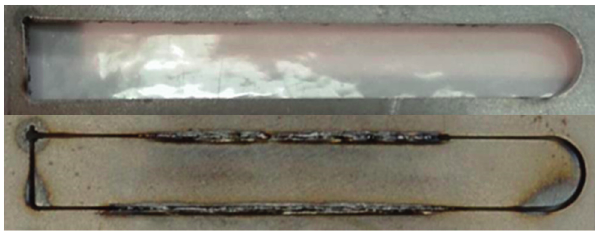
Figure 3. Picture of the complete cut ( top ) and incomplete cut ( bottom ) with the cut interruption on both straight